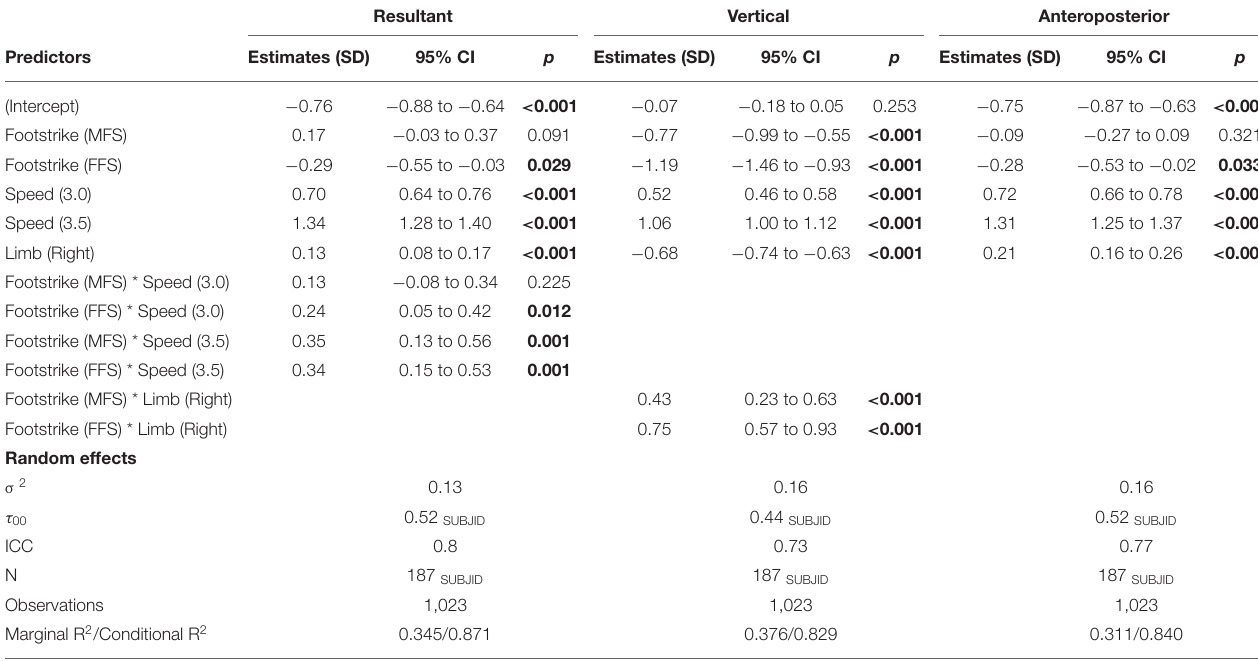
Referent categories are rearfoot strike, left limb, and speed of 2.5 m/s. MFS, midfoot strike; FFS, forefoot strike. Significant (p < 0.05) values are in bold.